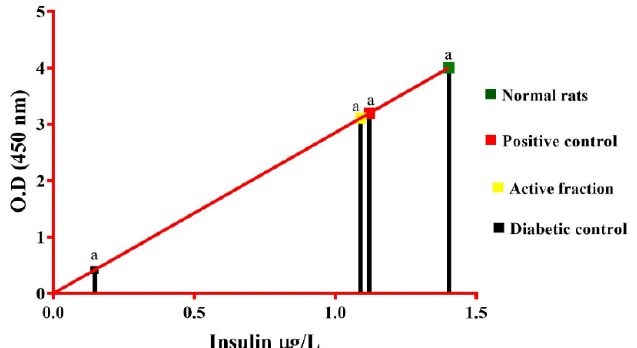
Figure 12. Effect of serum insulin level on experimental rats. The serum insulin level of the experi- mental groups was measured on the 14th day. ‘a’ denotes serum insulin concentration. Each value is